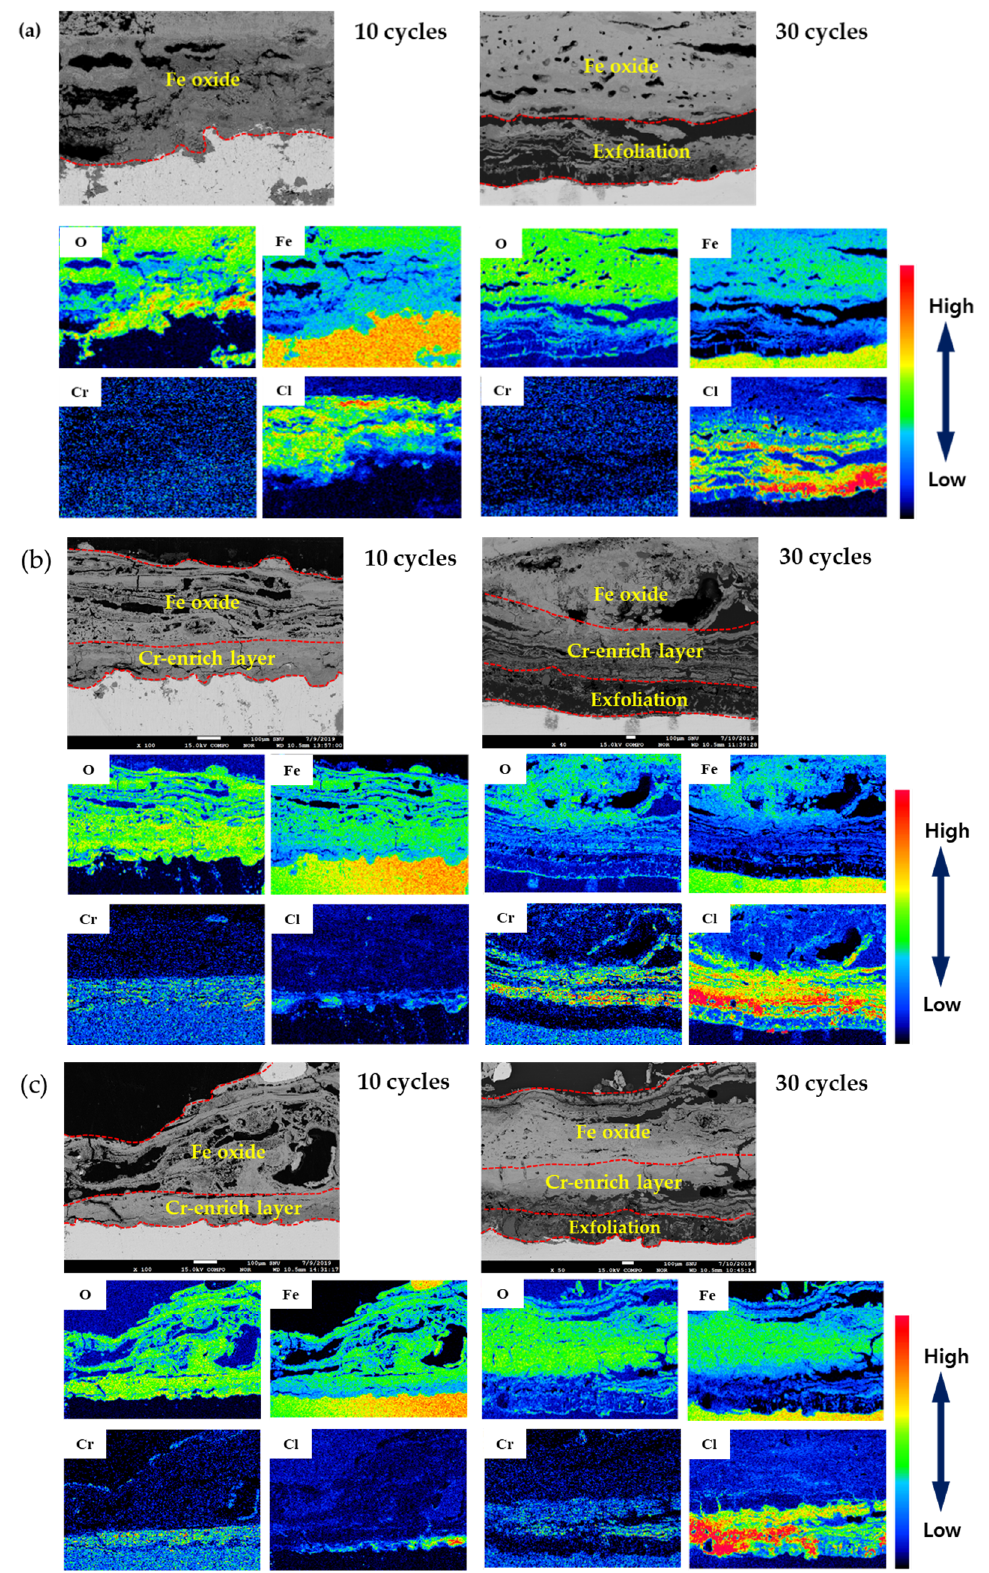
Figure 8. EPMA analysis of ( a ) 0 Cr steel, ( b ) 0.3 Cr steel, and ( c ) 0.5 Cr steel after CCT.